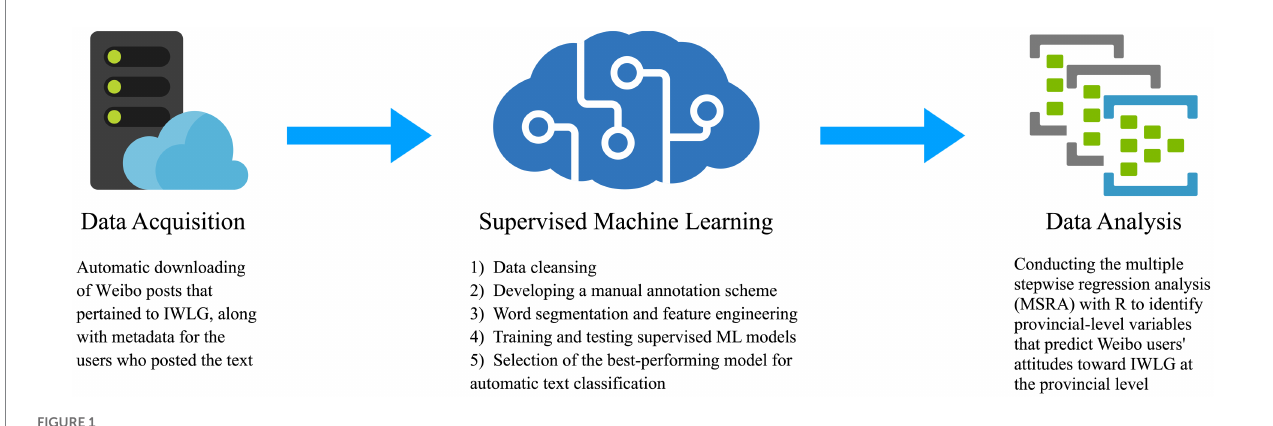
FIGURE 1 Methodology for data acquisition and